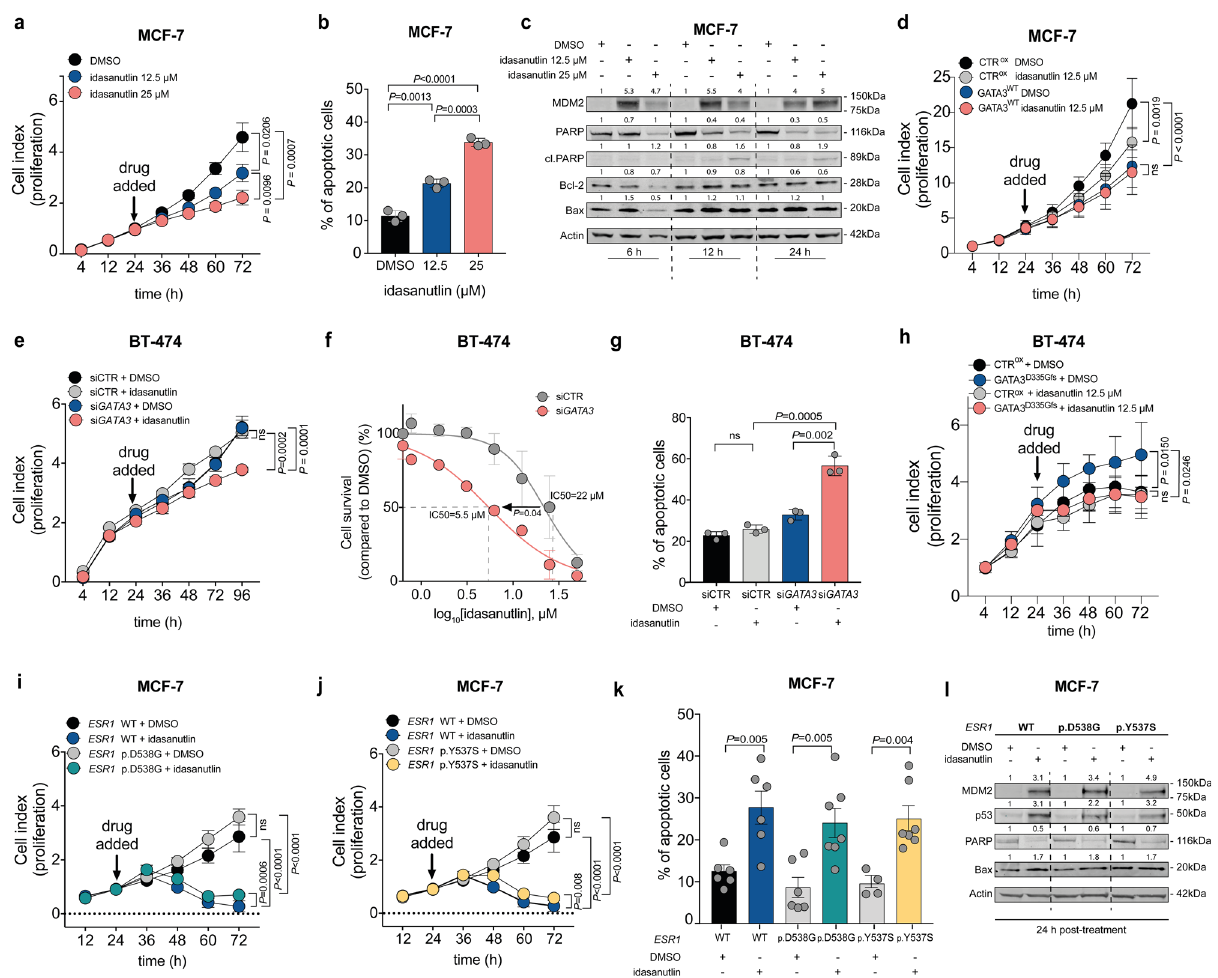
Fig. 2 GATA3 status determines response to MDM2 inhibitor in vitro. a , d , e , h , i , j Proliferation kinetics of a GATA3 -mutant MCF-7 under